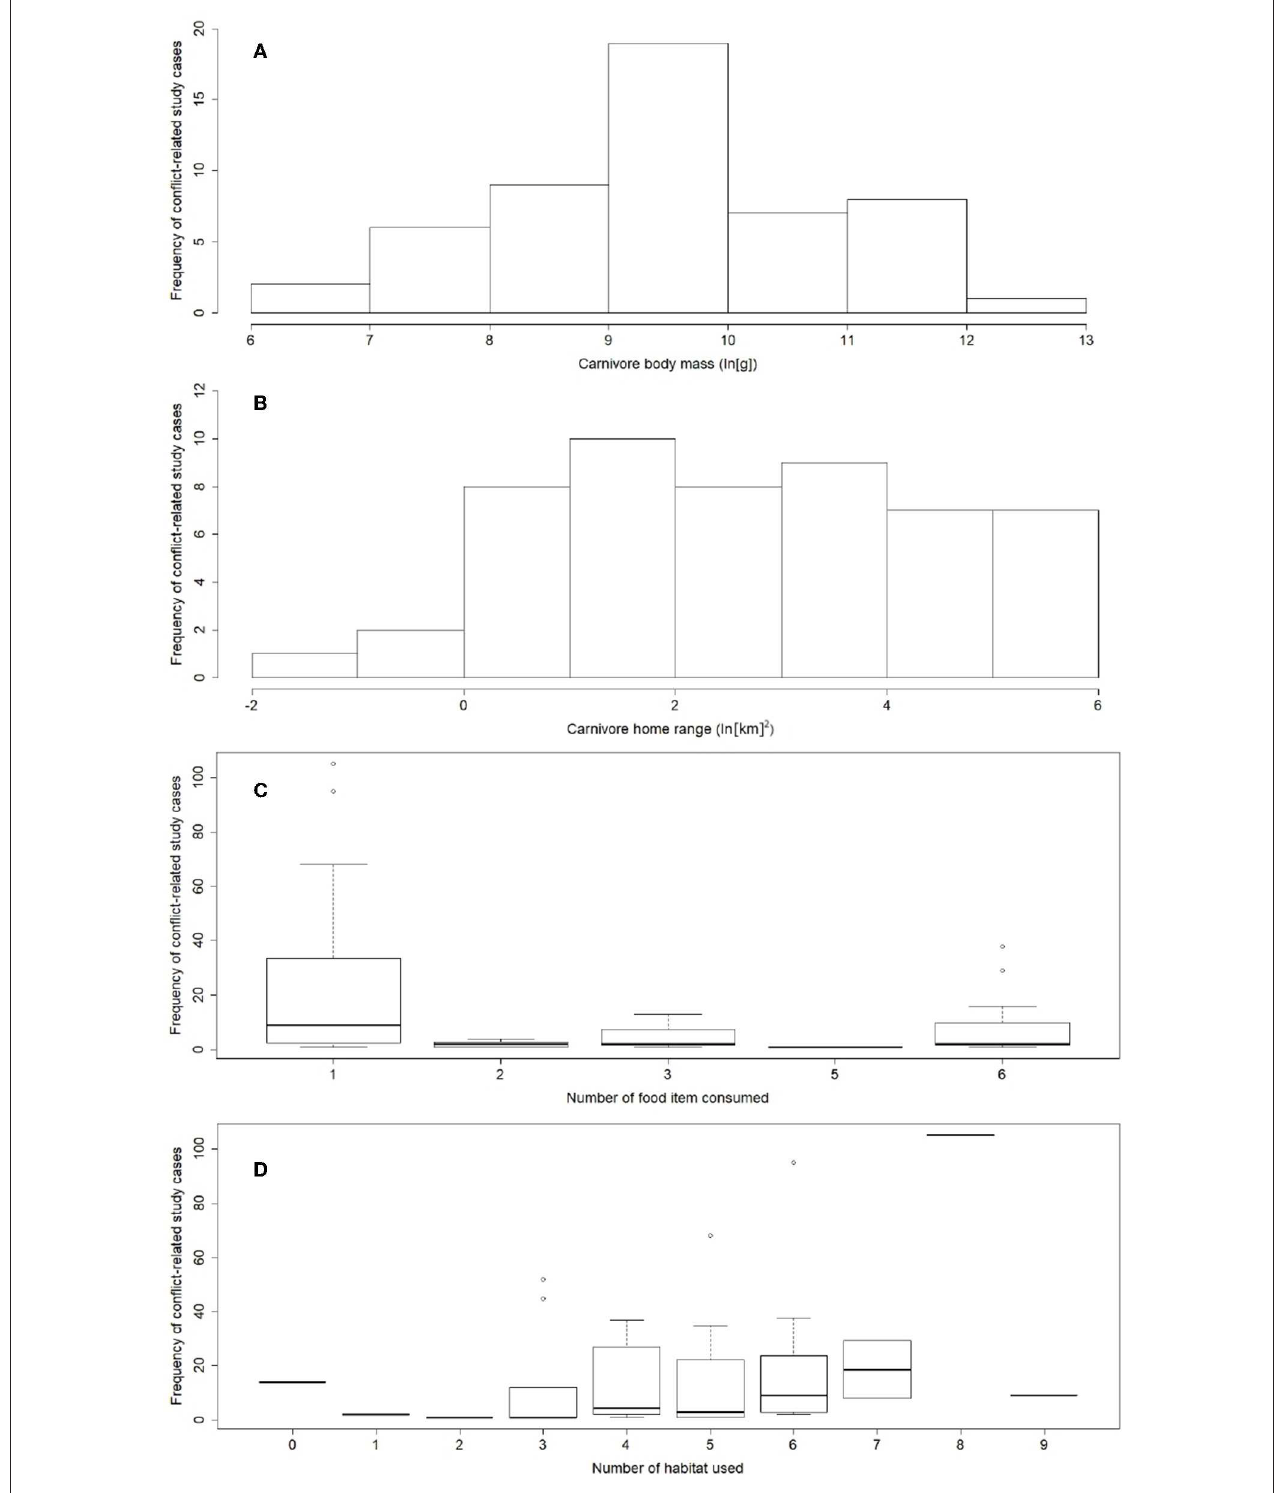
FIGURE 3 | Ecological diversity of carnivores reported in the reviewed carnivore-livestock conflict publications. (A) Predators spanning a wide range of body sizes were reported. (B) Home range sizes of species studied were diverse. (C) Conflict-related research effort focused on carnivores using a diverse range of habitats and (D) showing a narrow dietary breadth. Trait data were taken from a sample of 52 species, and reported frequency from 783 study cases (information available upon request).